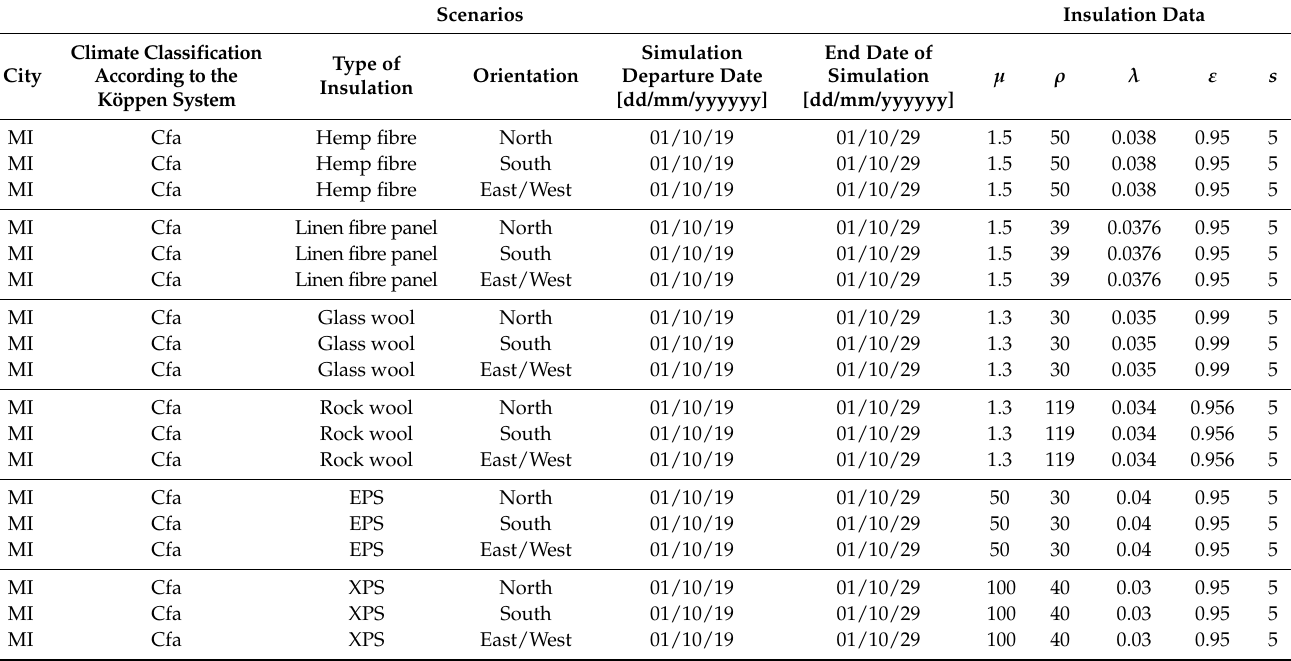
Table 1. Input data concerning the city of Milan, with a total of 18 numerical simulations for each location, for a total of 108 simulations in the variable regime considering all the chosen